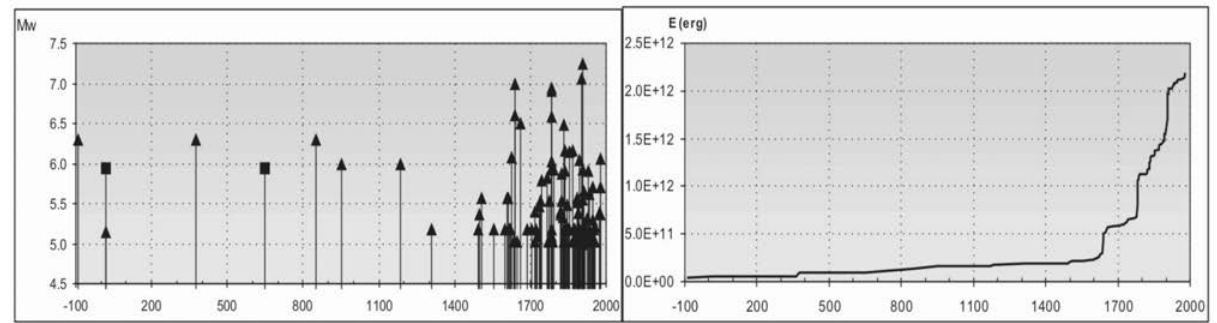
Figure 2. Temporal distribution of earthquakes in southern Calabria and north-eastern Sicily. (a) Magnitude vs. years. Squares show the 17 AD earthquake revaluated in this work and the unknown 7th century AD earthquake found by Galli and Scionti [2006] in northern Cal- abria; (b) Energy release, evaluated using the magnitude-energy relationship Log E-11.3+1.8 M [Gutenberg and Richter 1956]. Note that most of the events recorded in the catalogue occurred since 17th